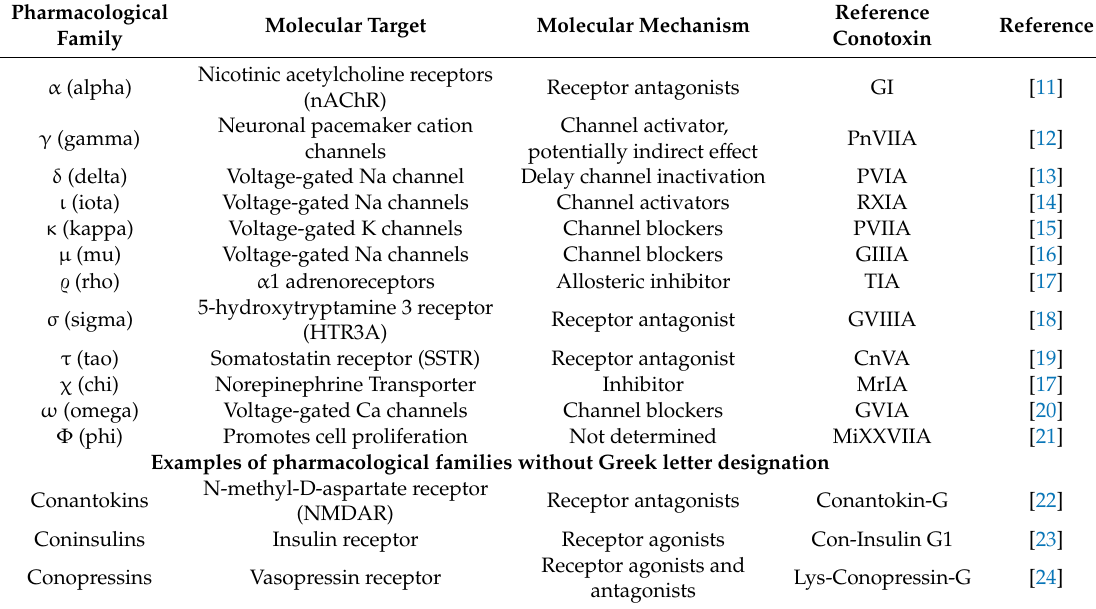
Table 1. Pharmacological families of conotoxins (in alphabetical order, modified from [10]).